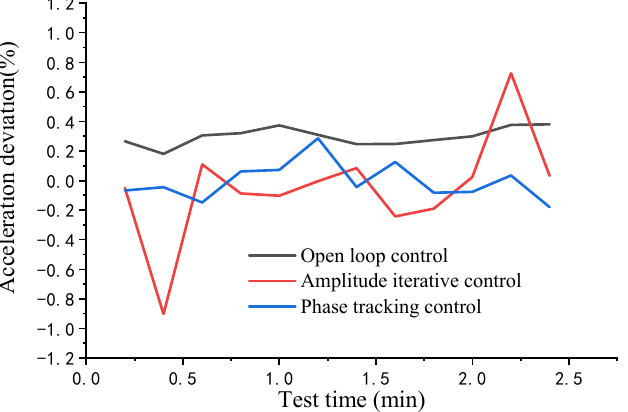
Figure 12. Amplitude stability comparison in the 4000 m/s 2 interval.